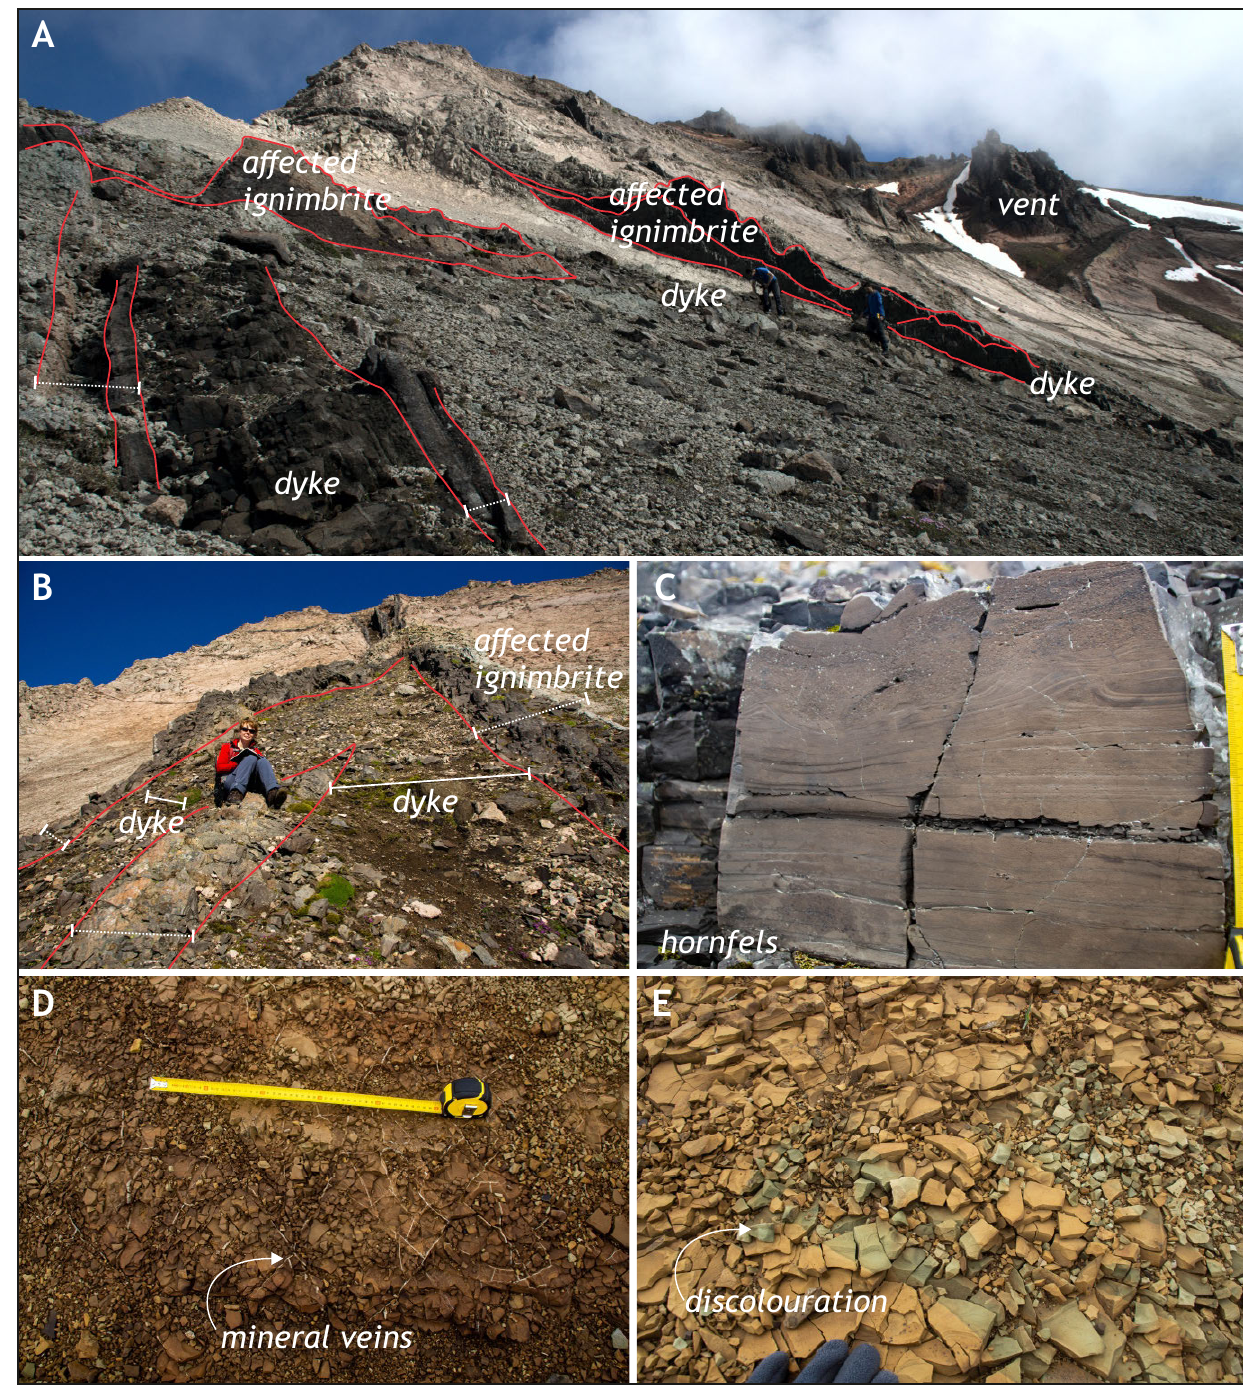
Figure 3: Field photographs of observations that indicate geothermal activity associated with dykes and sills in the study area. Photograph locations are indicated in Figure 2. [A] View of dykes and a vent in ignimbrite in Hvítserkur. Note that dykes are flanked by a contact aureole of black, glassy looking ignimbrite cm to m thick, as well as discoloured ignimbrite. Red lines outline the affected ignimbrite. Dotted lines indicate the width of ignimbrite affected by the dyke in the foreground. See people for scale. The unaffected paler ignimbrite is seen in the background. [B] Example of two adjacent dykes in Hvítserkur flanked by glassy and discoloured ignimbrite. Dotted lines indicate the width of ignimbrite affected by the two marked dykes. The solid lines indicate the width of the dykes. See person for scale. The unaffected paler ignimbrite is seen in the background. [C] Hornfels of lacustrine sedimentary rock located 3 m above the thickest sill in Leirfjall. Tape measure is 0.2 m long. [D] Network of mineral veins in mudstone located within 10 m above the thickest sill in Leirfjall. Tape measure is 0.5 m long. [E] Localised veins of greenish discolouration of mudstone occur in the 10 m above the thickest sill in Leirfjall. Glove for